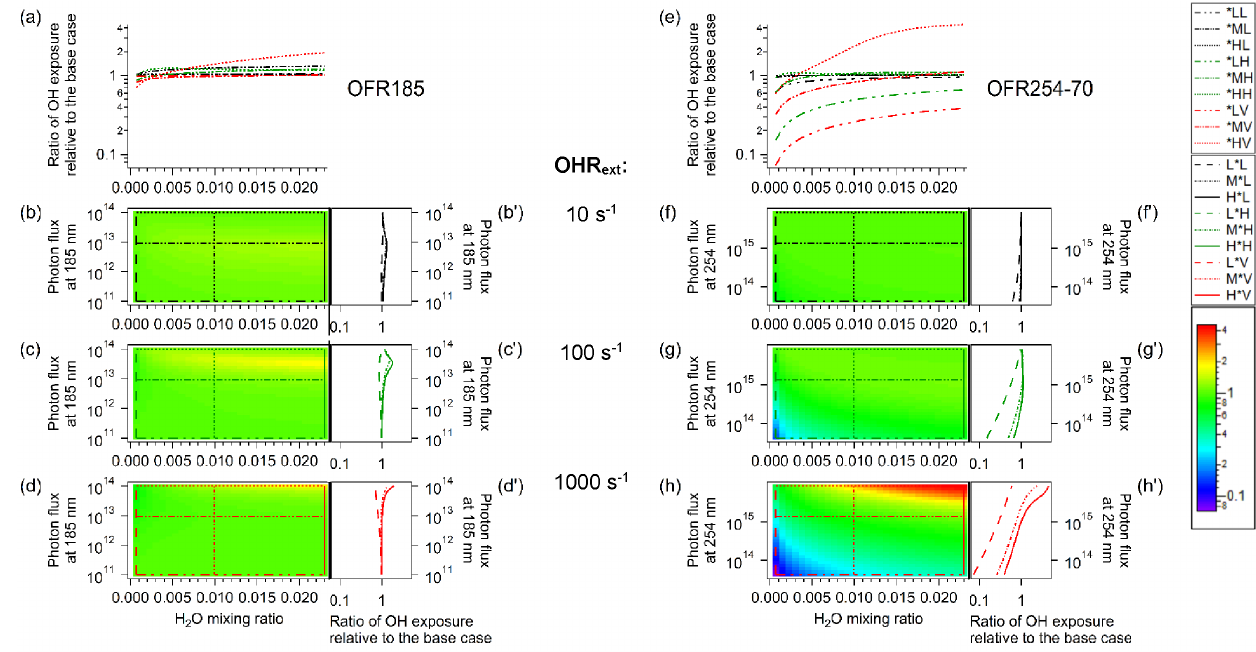
Figure 7. Percentage of OH exposure in the case of HO x -destructive external OH reactivity (OHR ext ) relative to that in the base case (Fig. 2) vs. the same parameters and in the same format as Fig. 2, but for the cases of low (10s − 1 ), high (100s − 1 ), and very high (1000s − 1 ) external OH